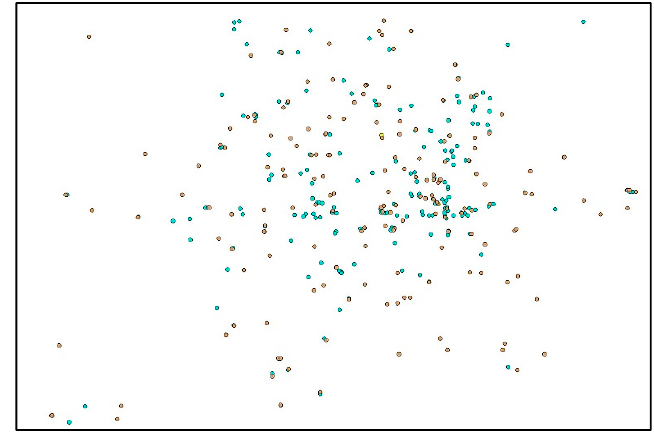
Figure 13. In our research region, the blue POIs represent Starbucks while the yellow POIs represent the cinema. This figure shows their spatial distribution characteristics.